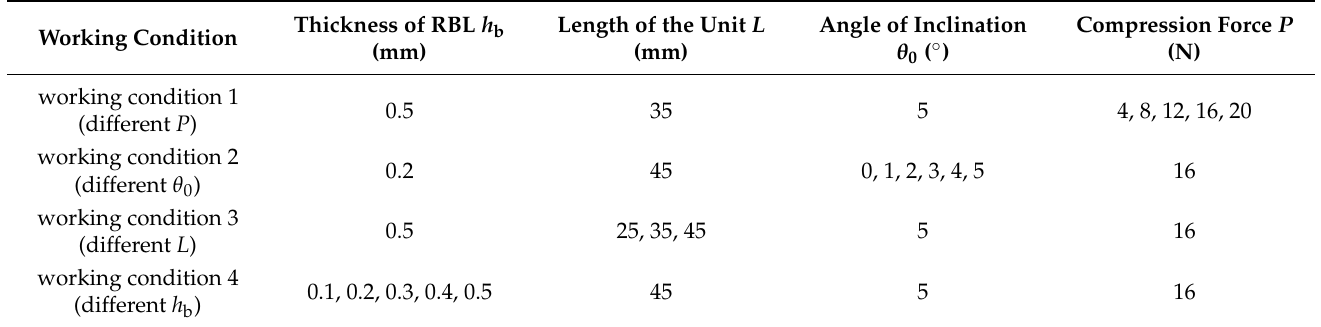
Table 2. Working conditions of the adhesive unit during compression and